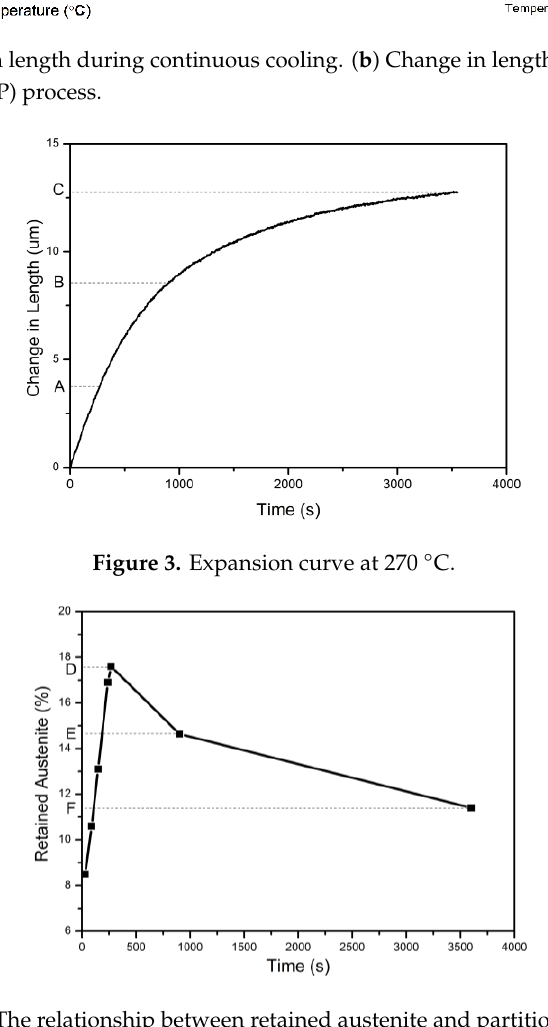
Figure 4. The relationship between retained austenite and partitioning time. (Figure 3: B,C), corresponding to the metastable austenite decomposition of 2.53% (Figure 4: